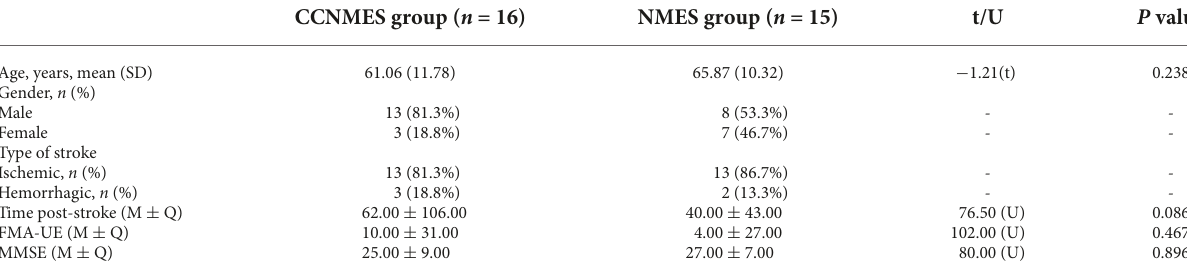
TABLE 1 Demographics and characteristics of the stroke patients in the two groups.